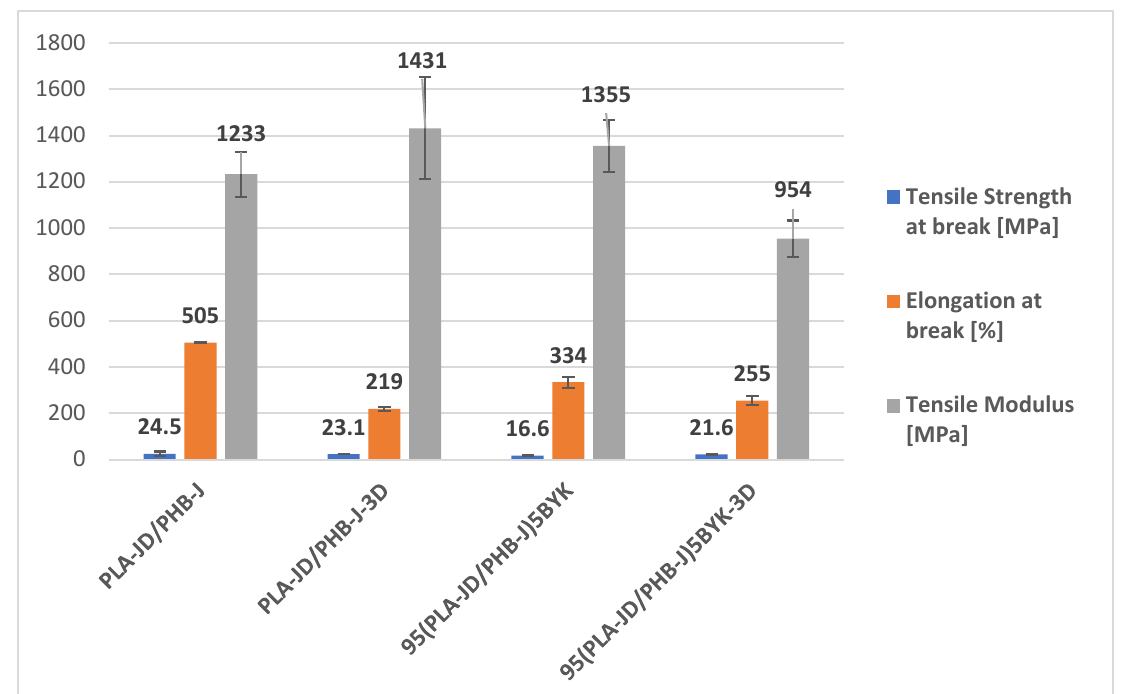
Figure 6. Column graph of tensile strength at break, elongation at break, and tensile modulus for PLA-JD/PHB-J and 95(PLA-JD/PHB-J)5BYK injected and printed blends.